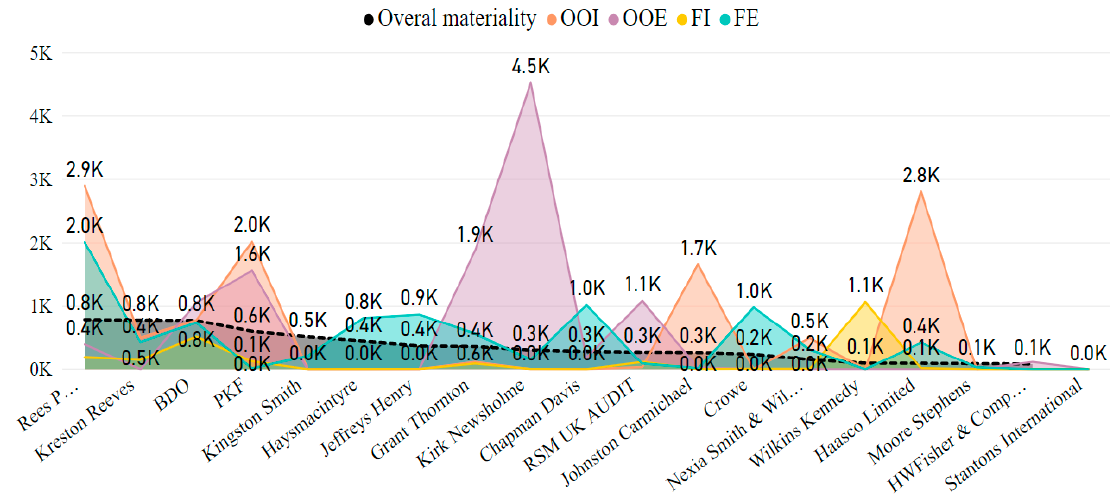
Figure 15. Average values of OOI, OOE, FI, and FE in relation to the OM—for non-Big 4 auditing firms. Source: own elaboration based on analyzed data.